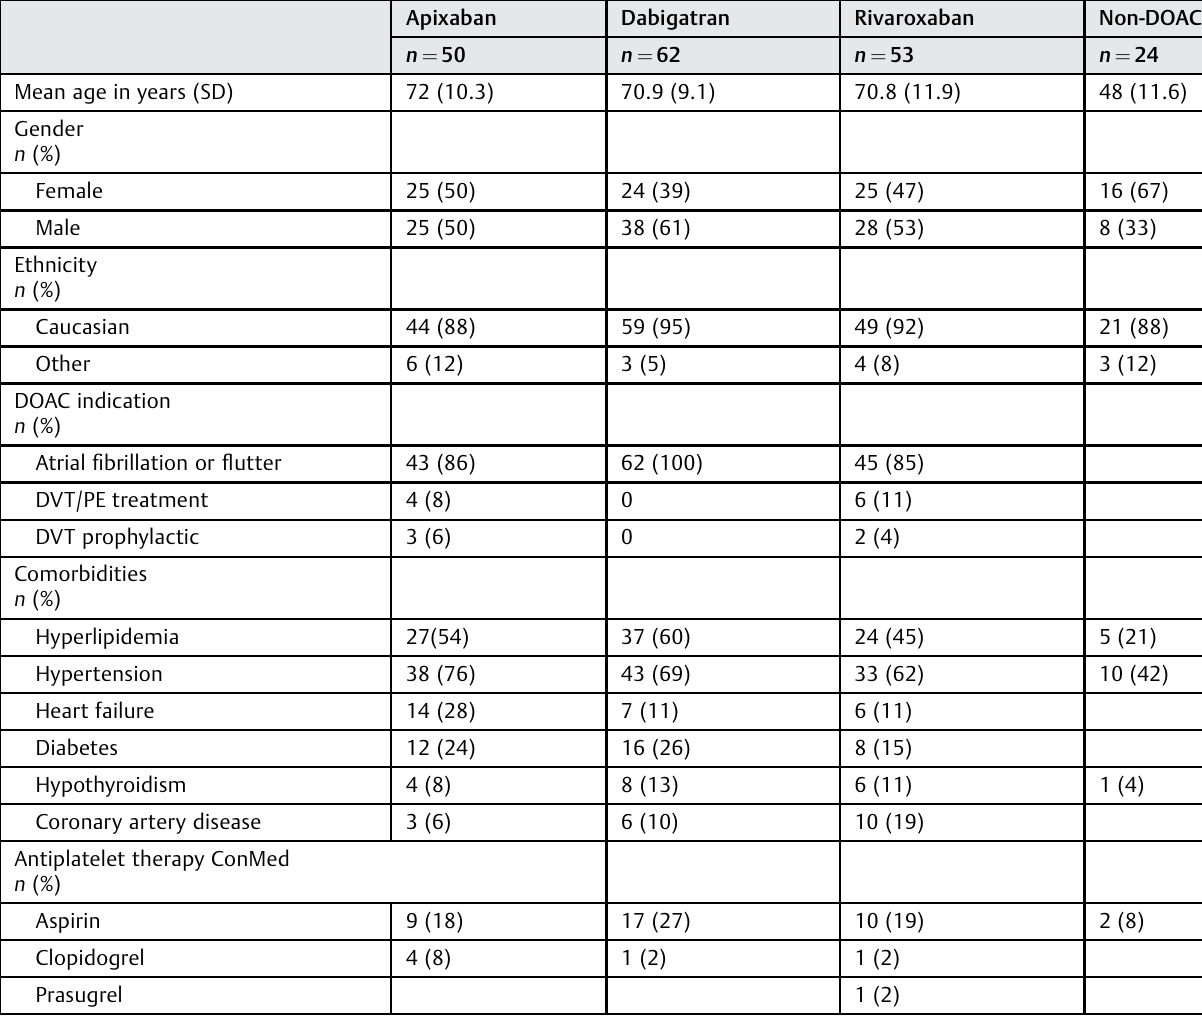
Table 1 Subjects clinical